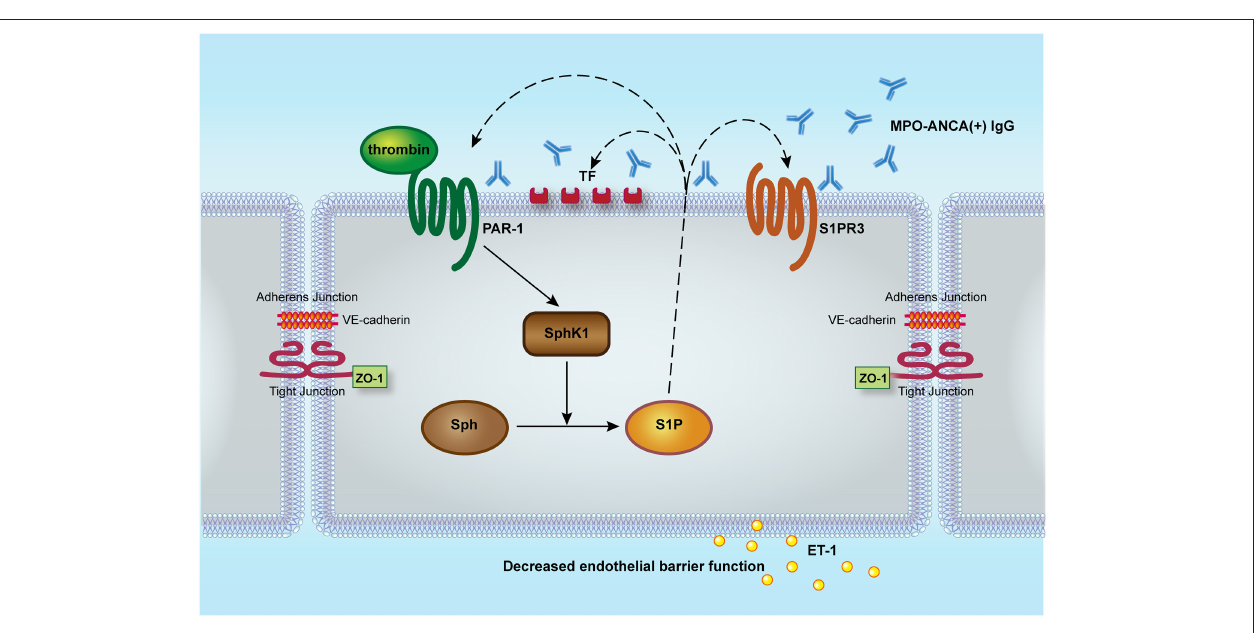
FIGURE 6 | Proposed working model for the role of SphK1-S1P-S1PR3 in thrombin-induced GEnC activation in the presence of MPO-ANCA-positive IgG. Thrombin could enhance MPO-ANCA-positive IgG-induced GEnC activation and injury via PAR1. At the same time, thrombin might activate SphK1-S1P-S1PR3 axis in